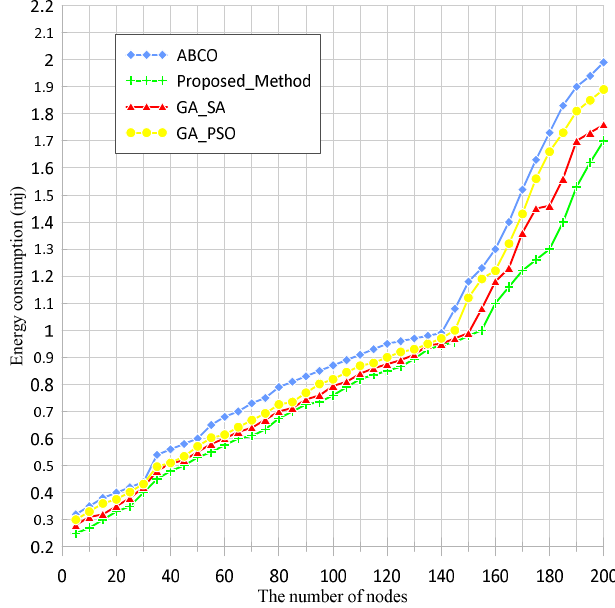
Figure 6. Comparison of the energy consumption.